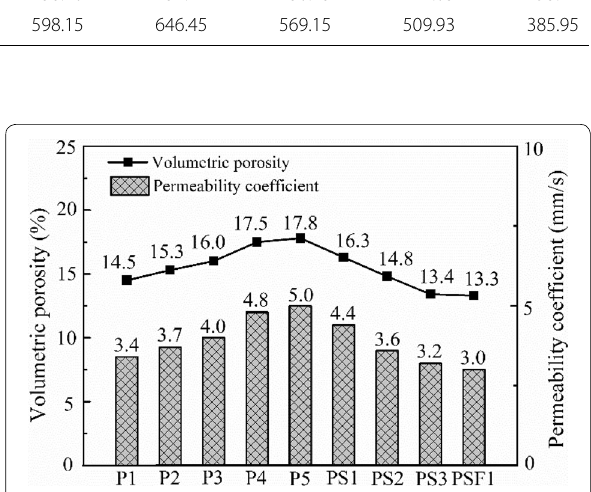
Fig. 7 Comparison of the permeability coefficient and volumetric porosity of pervious concrete